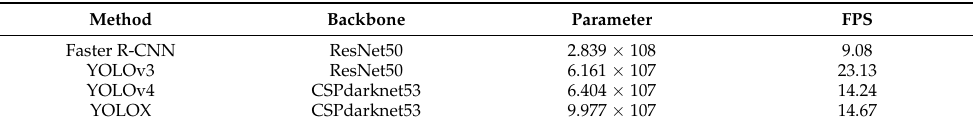
Table 9. Parameters and FPS of different models.